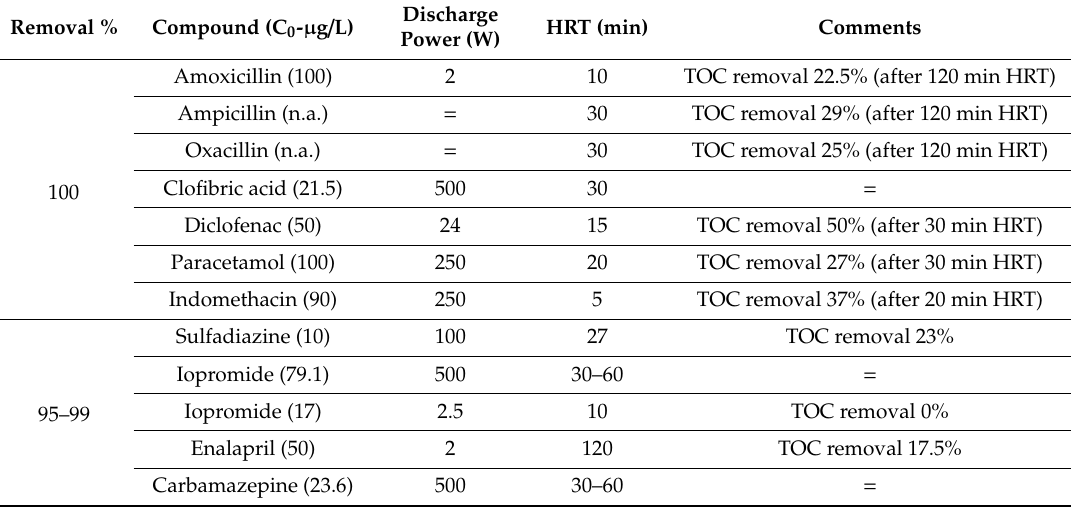
Table 5. Summary of results reported on pharmaceuticals degradation by